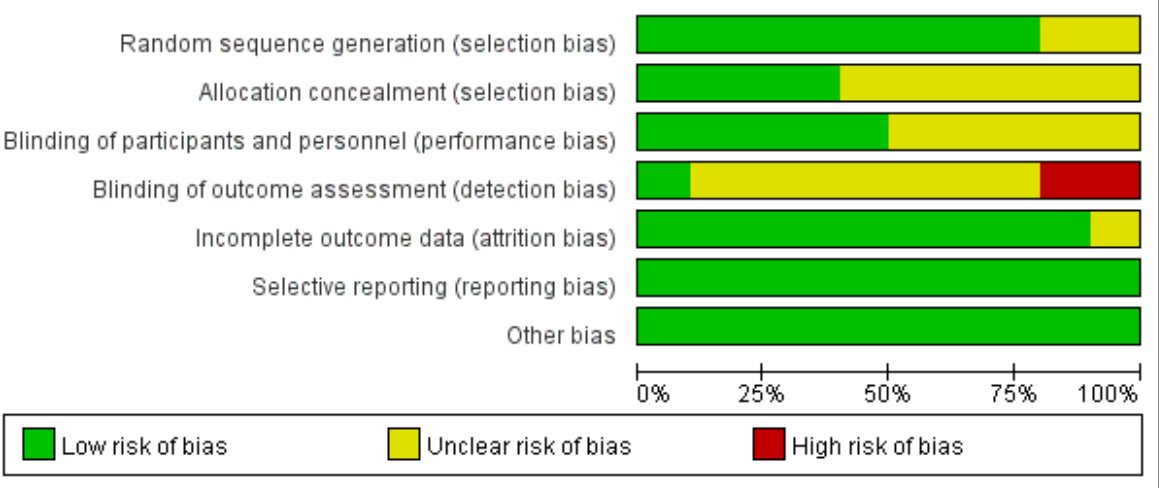
Figure 2. Risk of bias graph for RCTs and crossover controlled trials.